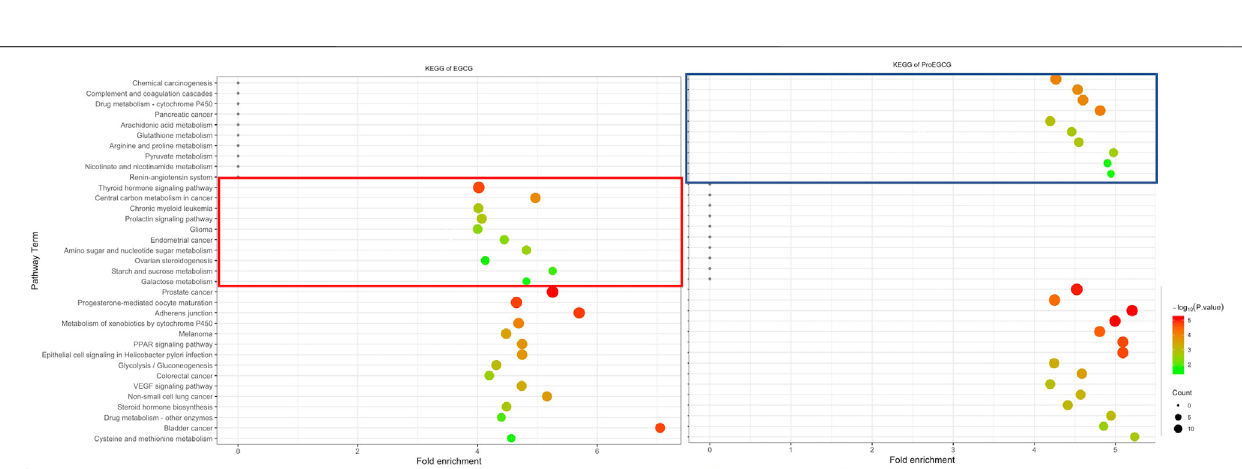
Frontiers in Pharmacology |